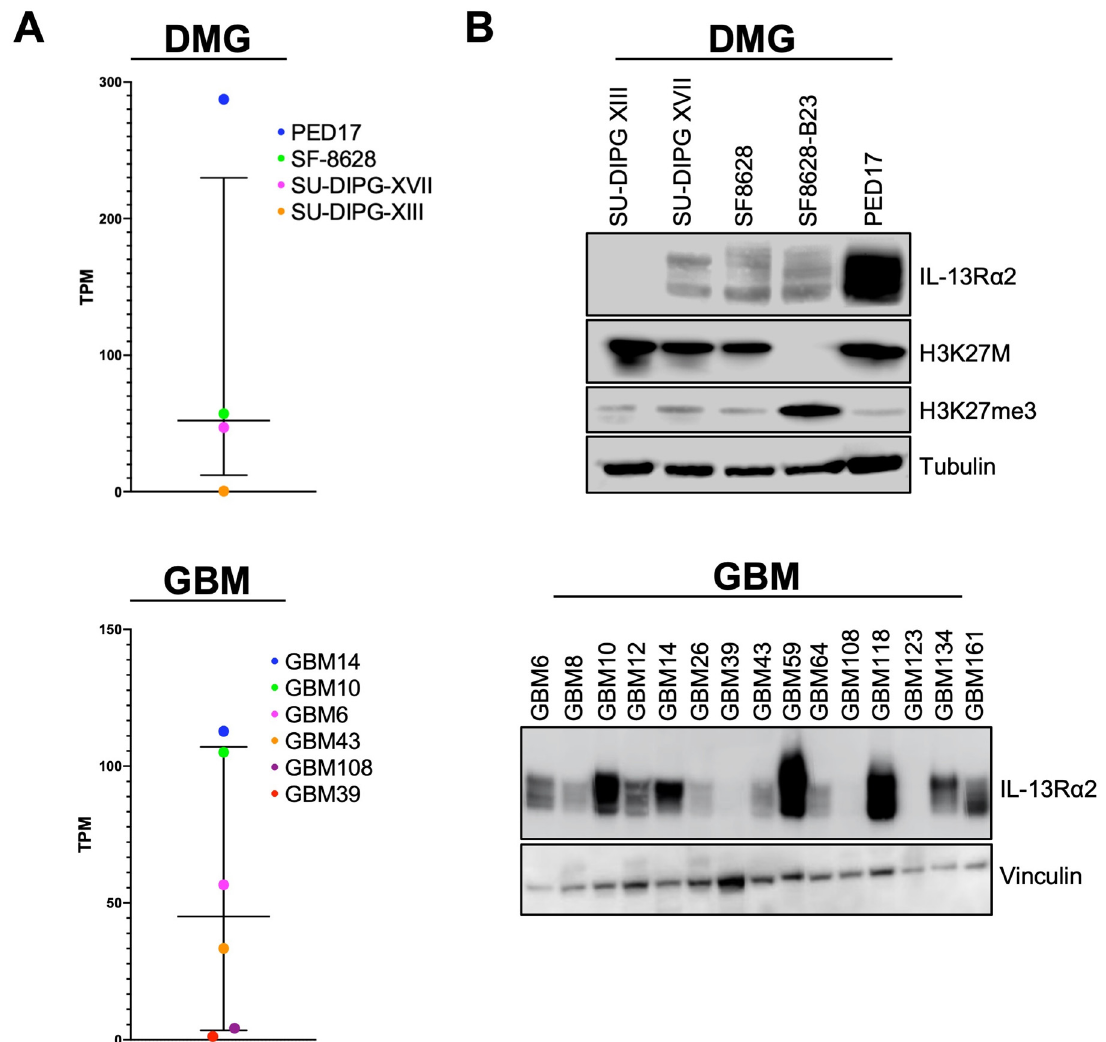
Figure 1. High-grade glioma (HGG) cell lines demonstrate a spectrum of IL-13R α 2 expression on both the mRNA and protein level. ( A ) RNA-Seq and ( B ) immunoblotting of diffuse midline glioma (DMG) and adult glioblastoma (GBM) cell models indicates a correlation between mRNA and protein levels of IL-13R α 2 at baseline. Cell lines differ in terms of IL-13R α 2 expression.